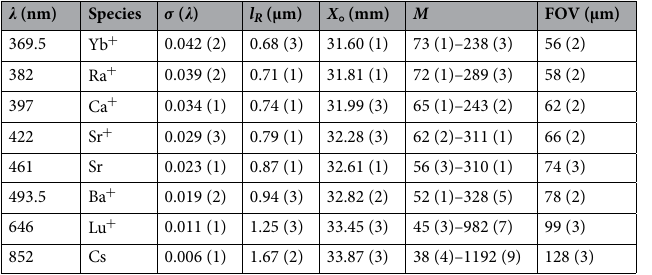
Table 3. Estimated values of various optical excellence parameters obtained using OSLO for wavelengths corresponding to different atom/ion species.